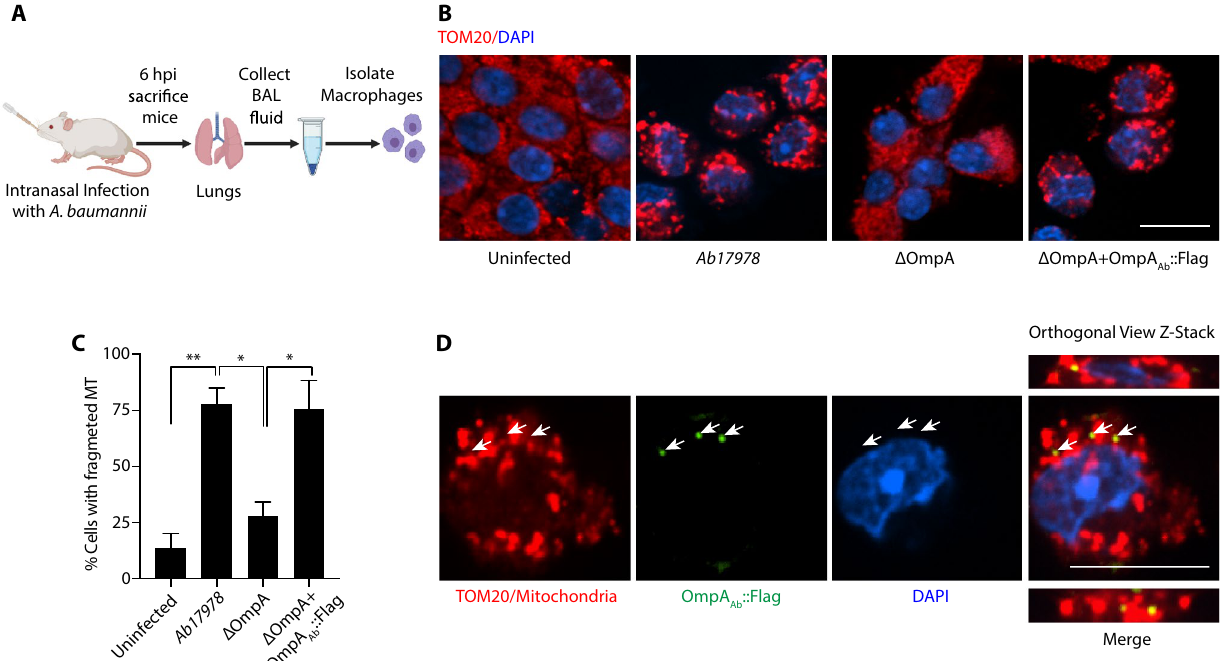
Figure 6. OmpA Ab induces mitochondrial fragmentation in vivo . ( A ) Illustration of the mouse infection (created with BioRender.com). ( B ) Neutropenic BALB/c mice were infected intranasally with 10 7 colony forming units (CFUs) of the indicated bacteria. Six hours post-infection bronchoalveolar lavage (BAL) fluid was collected from the trachea of mice. Alveolar macrophages were isolated and immunofluorescence was performed using anti-TOM20 antibody to stain mitochondria (red) and DAPI to stain nuclei. Scale bar represents 10 µm. ( C ) Quantification of cells with fragmented mitochondria. The cells displaying a discontinuous segmented mitochondrial network were scored as fragmented. The quantification was performed in a blinded manner. Error bars represent standard deviation, n = 157–521 cells. One-way ANOVA with Tukey’s multiple comparisons test * p ≤ 0.05, ** p ≤ 0.01. ( D ) Immunofluorescence was performed on the alveolar macrophages isolated from the BAL fluid from mice infected with ΔOmpA + OmpA Ab ::Flag complemented strain using anti-TOM20 antibody to stain mitochondria (red), anti-Flag antibody to stain OmpA::Flag (green) and DAPI to stain the nucleus (blue). Arrows indicate OmpA Ab ::Flag (green) colocalization with mitochondria (red). Scale bar represents 10 (400 µg/ml; based on BCA protein estimation assay). Consistent with our previous results, treatment of A549 cells with OMVs isolated from wildtype A. baumannii induced mitochondrial fragmentation but not OMVs isolated from A. baumannii ΔOmpA (Fig. 5E,F). To ascertain the sufficiency of OmpA Ab in inducing mitochondrial fragmentation, OMVs from E. coli ΔOmpA Ec ,OmpA Ab and E. coli ΔOmpA Ec EV were isolated and verified by visualization using electron microscopy (Supplementary Fig. 4C) and western blotting using an antibody against BamA, an outer membrane protein in E. coli (Fig. 5G). The presence of OmpA Ab only in the OMV preparations from E. coli ΔOmpA Ec ,OmpA Ab but not from E. coli ΔOmpA Ec EV was confirmed by western blotting for the FLAG tag that is fused to the OmpA Ab protein; the FLAG signal was only present in the OMV preparation from E. coli ΔOmpA Ec ,OmpA Ab and not in the OMV preparation from E. coli ΔOmpA Ec EV (Fig. 5G). Furthermore, contamination of OMVs with bacterial inner membrane was ruled out by western blotting using an antibody against MsbA, an inner membrane protein (Supplementary Fig. 4D). We then treated A549 cells with these OMVs (400 µg/ml; based on BCA protein estima- tion assay) and observed mitochondrial fragmentation in cells treated with OMVs from E. coli ΔOmpA Ec ,OmpA Ab (Fig. 5H,I). By contrast, there was no difference observed between the mitochondria of untreated cells and the cells treated with OMVs isolated from E. coli ΔOmpA Ec EV (Fig. 5H,I). We also assessed cytotoxicity and found that the presence of OmpA Ab in OMVs increased cytotoxicity in a concentration dependent manner (Fig. 5J). Together these data indicate that OmpA Ab is necessary and sufficient to cause mitochondrial perturbation in the context of infection by intact bacterial cells (Fig. 2F–I) as well as by its presence in OMVs (Fig. 5E,F,H,I). We next monitored fluorescently-labelled OMVs intracellularly in host epithelial cells. Isolated OMVs from E. coli ΔOmpA Ec ,OmpA Ab were labelled with the fluorescent dye Vybrant-DiO and then incubated with A549 cells (400 µg/ml; based on BCA protein estimation assay) for 6 h. Fluorescently-labelled OMVs could be detected within A549 cells after 6 h and intriguingly a large proportion of OMVs directly colocalized with mitochondria as revealed by confocal Z-stack microscopy (Fig. 5K; Supplementary Fig. 4E). We next asked if the presence of OmpA Ab was required for the localization of OMVs to mitochondria. Interestingly, OMVs from E. coli ΔOmpA Ec EV also colocalized with mitochondria suggesting that mitochondrial localization of OMVs did not depend on the presence of OmpA Ab (Fig. 5L; Supplementary Fig. 4E). However, as described earlier mitochondrial